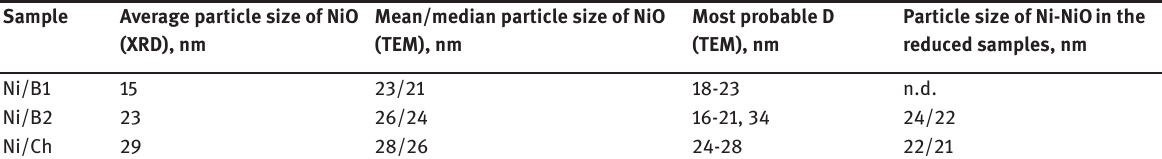
Table 2: Average sizes of Ni-containing particles by TEM and XRD. Sample